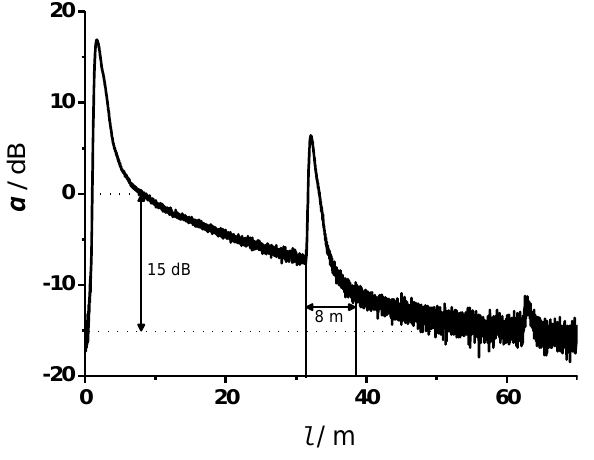
Figure 3. Converted OTDR trace (attenuation versus fiber length). The parameters determined with these data are: dynamic range = 15 dB, attenuation dead zone = 8